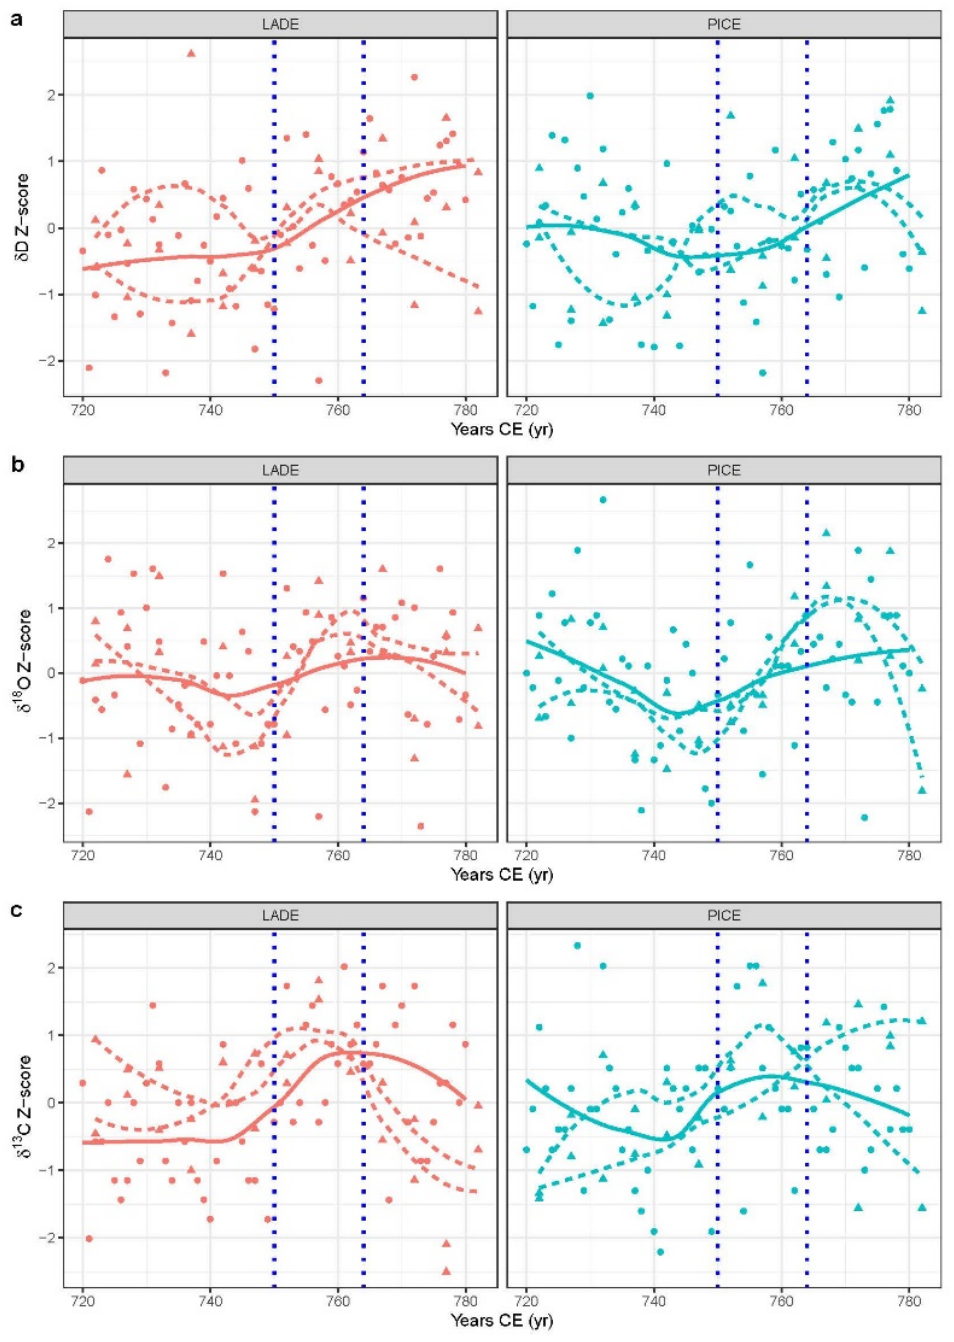
Figure 4. Plots of tree-ring cellulose isotope series in mid-8th-century eruptions attributed to Icelandic volcanoes; the points are the individual measurements, and the lines are the spline of each tree. The values of the series with annual resolution are shown by the continuous lines, while the values of the series with 5-year resolution are given by the dotted lines. The left column shows the values of larch samples (LADE, in red) and the right column shows the values of cembran pine (PICE, blue). The vertical dotted lines indicate the years of the eruptions (750 and 764 CE). Panel ( a ): δ D values. Panel ( b ): δ 18 O values. Panel ( c ): δ 13 C values.